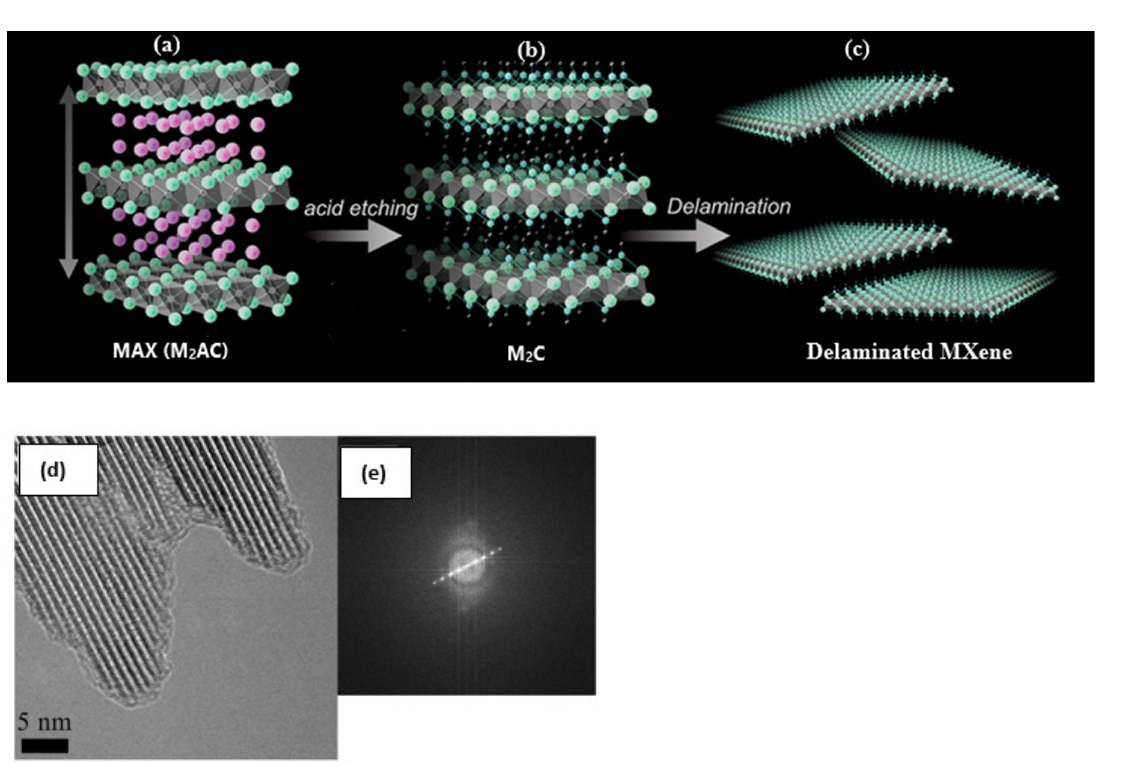
Figure 2. Schematic illustration showing ( a – c ) synthesis of delaminated MXene. Modified from [25], with permission from Wiley-VCH. 2016. ( d ) High Resolution TEM images with ( e ) the Fourier Transform, for delaminated Ti 3 C 2 Mxene [28]. Copyright (2017), with permission from Elsevier.